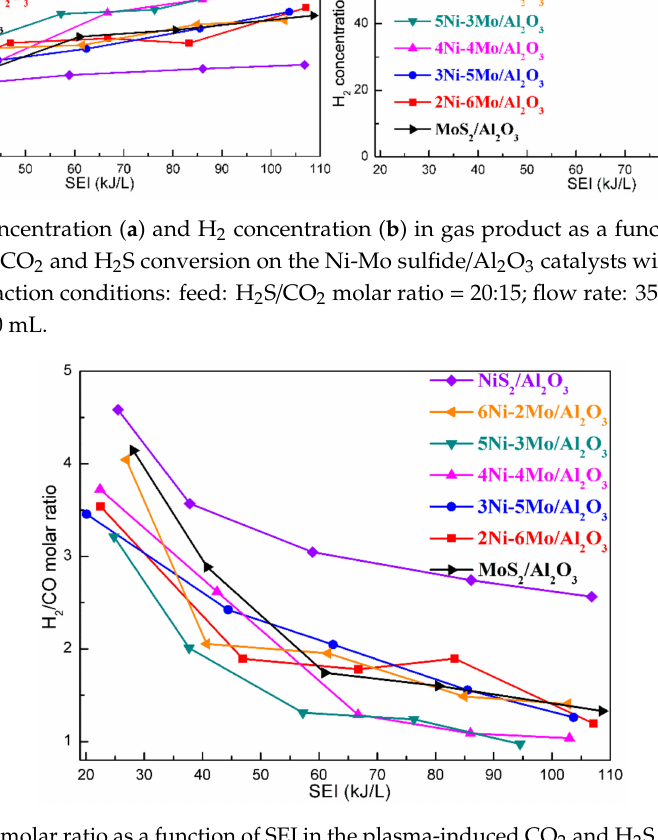
Figure 7. H 2 / CO molar ratio as a function of SEI in the plasma-induced CO 2 and H 2 S conversion on the Ni-Mo sulfide / Al 2 O 3 catalysts with various Ni / Mo molar ratios. Reaction conditions: feed: H 2 S / CO 2 molar ratio = 20:15; flow rate: 35 mL / min; catalyst bed volume: 15.0